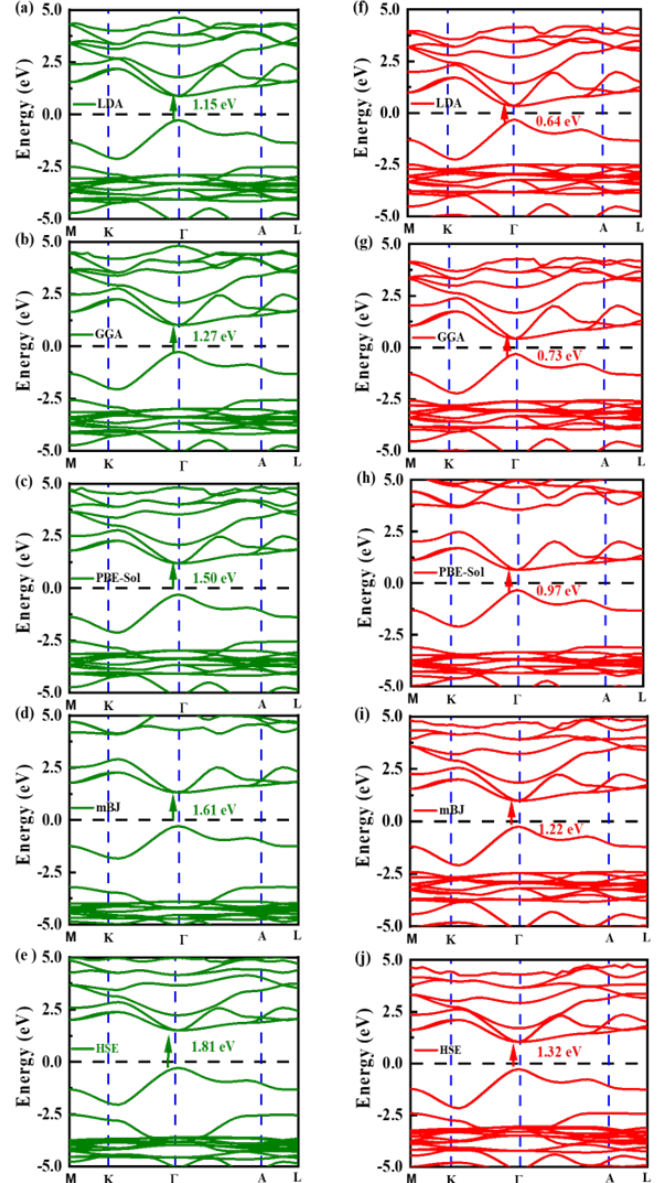
Figure 3. Band structure for ( a – e ) Rb 2 InBiCl 6 and ( f – j ) Rb 2 InBiBr 6 using different exchange corelation functionals .